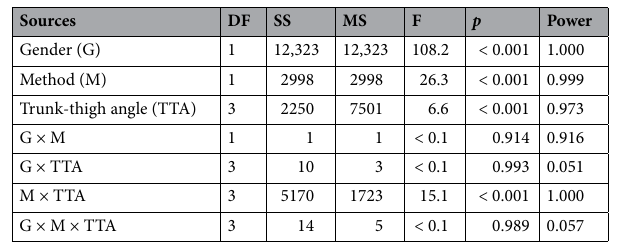
Table 2. Main and interaction effects of external ischial tuberosity widths obtained from three-way ANOVA.